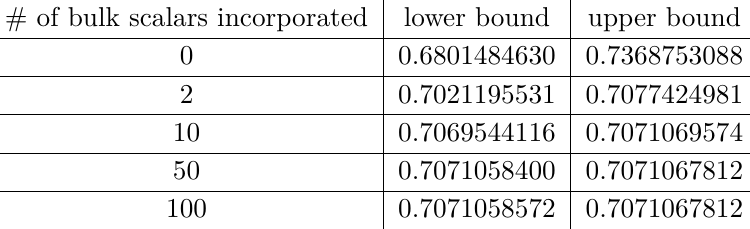
Table 8. Upper and lower bounds on the g function for stable boundary conditions in the Spin(8) 1 WZW model at N = 127 derivative order with an increasing number of low-lying bulk scalars incorporated. The bounds appear to be convergent upon 1 √